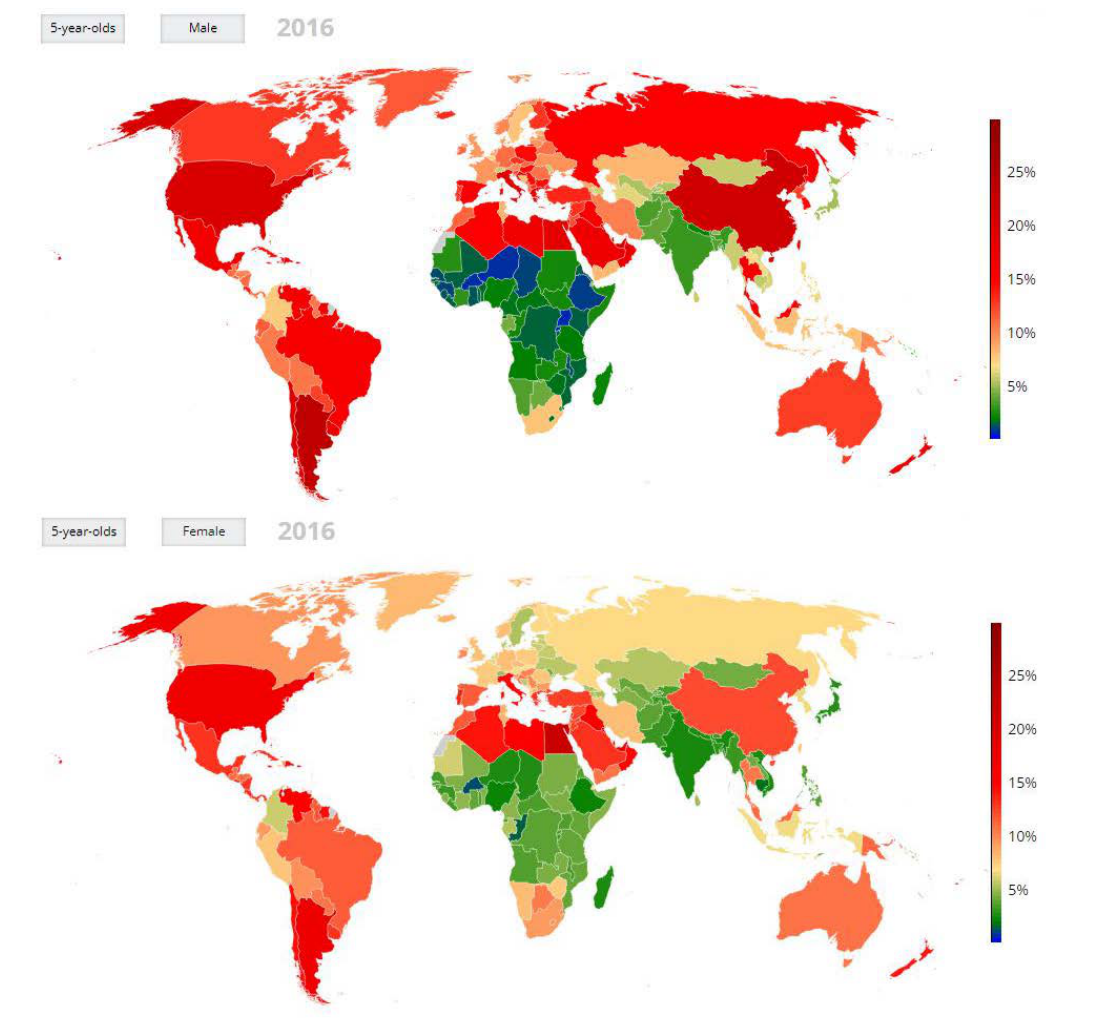
Figure 1. Global Prevalence Rates of Obesity in Five-Year-Olds (2016) [3].